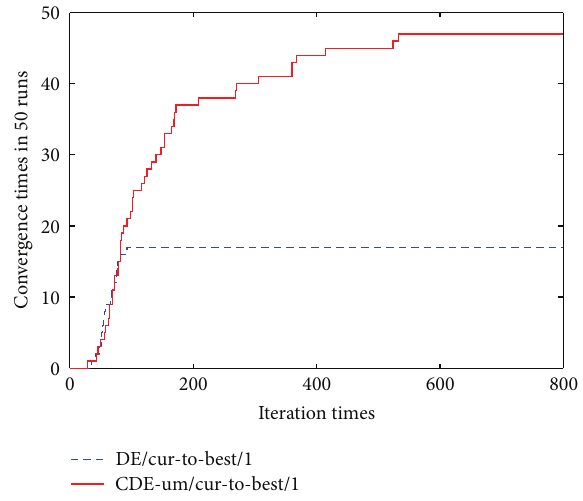
Figure 2: Convergence times figure in 50 runs for DE’s deceptive function using ∗ /cur-to-best/1